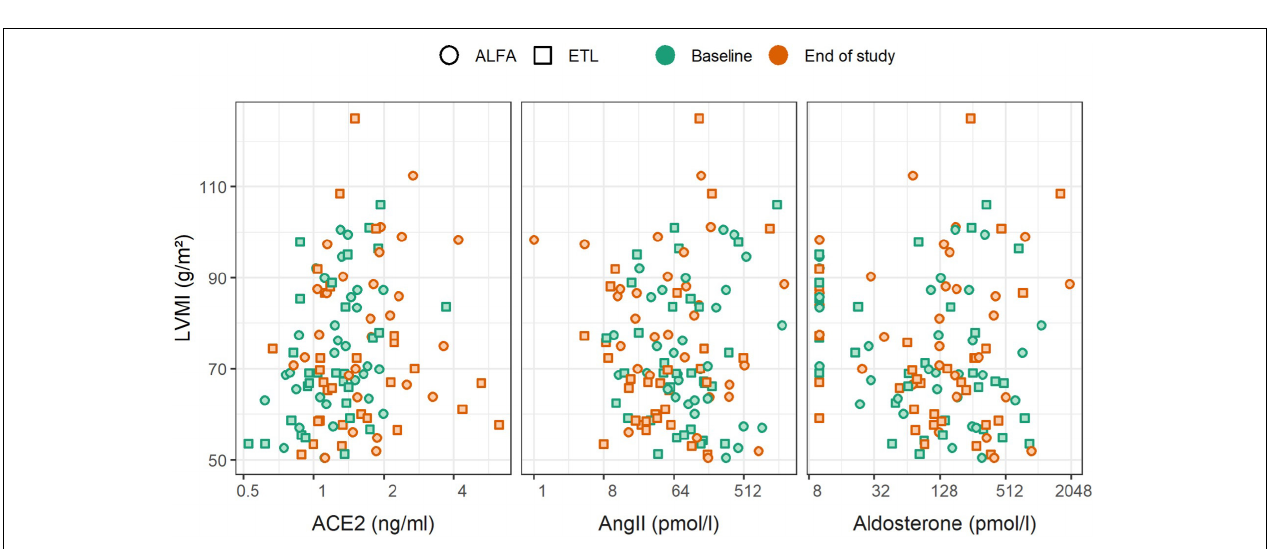
FIGURE 3 | Scatterplot of FGF23 levels and RAAS parameters stratified by the time of measurement (color) and study drug (shape). Changes of FGF23 were not associated with changes of RAAS parameters.